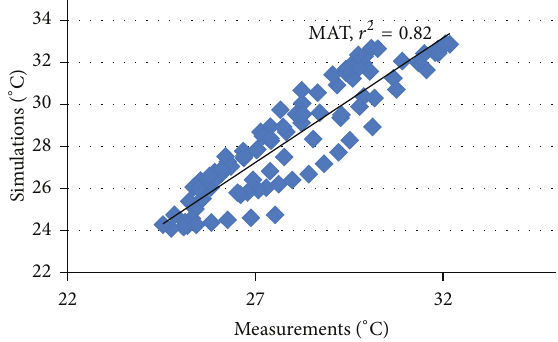
Figure 7: Measured versus simulated indoor air temperatures.